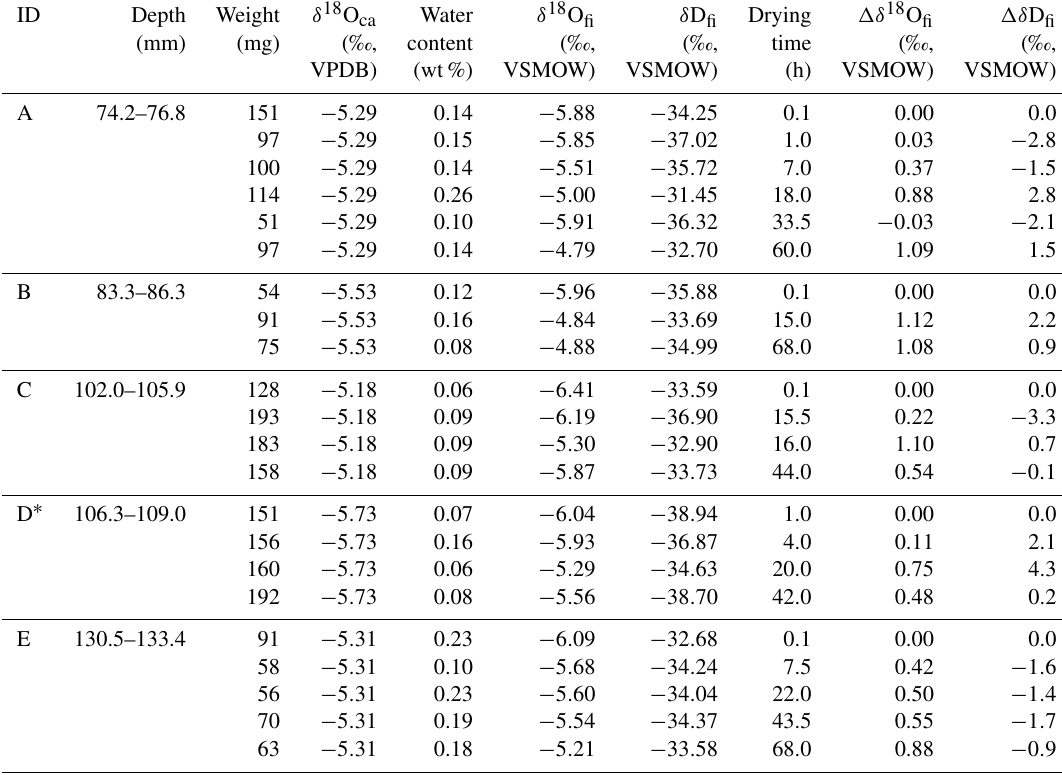
Table 1. Isotopic compositions of inclusion waters and calcite in the HSN1 stalagmite for the 105 ◦ C